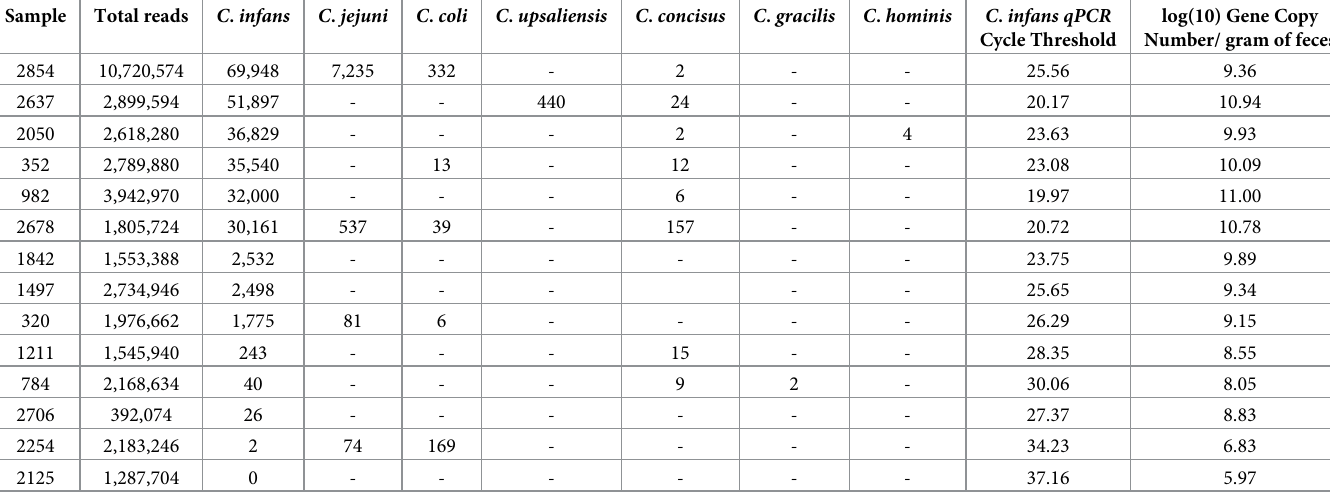
Table 3. Total number of reads and number of reads detected for Campylobacter infans , Campylobacter jejuni , Campylobacter coli , Campylobacter concisus , Cam- pylobacter upsaliensis , Campylobacter helveticus , Campylobacter gracilis and Campylobacter hominis from 14 stools that were PCR positive using the species-specific C . infans assay.